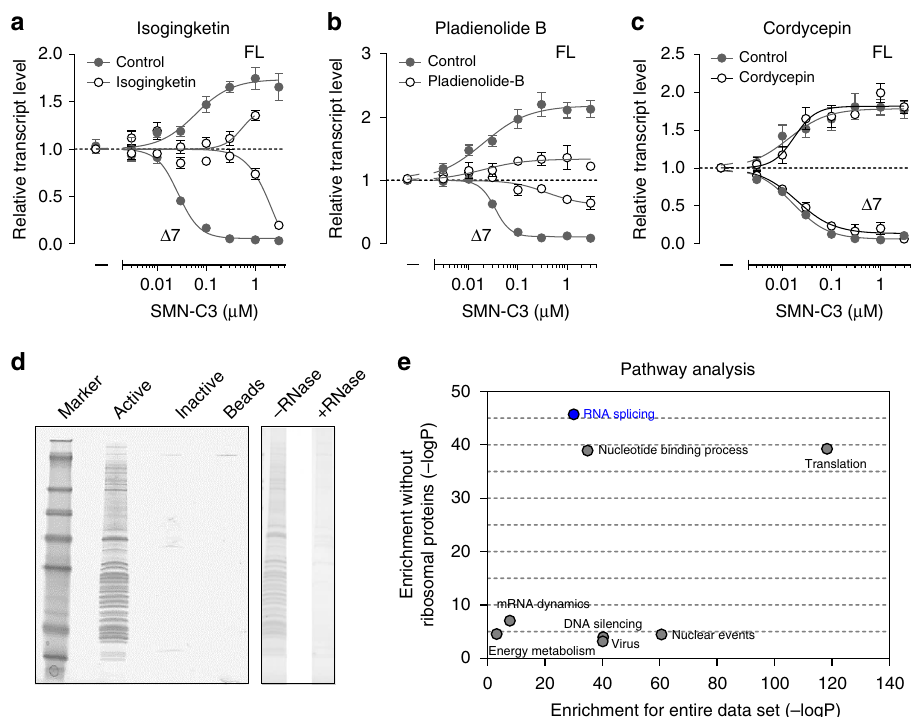
Fig. 1 Small molecule splicing modi fi ers act directly on the RNA splicing process. a , b , c RT-PCR analysis of SMN2 mRNA FL and Δ 7 relative transcript levels in SMA type 1 patient fi broblasts. SMN-C3 compound activity after 6 h treatment was investigated in the presence or absence of inhibitors of splicing or polyadenylation, namely 50 µ M isogingketin a , 100 nM pladienolide B b , or 40 µ M cordycepin c . d Coomassie gel after chemical proteomics showing proteins pulled down in the presence of Active vs. Inactive compound, as well as after RNase treatment. The full gel is illustrated in Supplementary Fig. 2H. e Pathway enrichment analysis of Active compound (SMN-C6), suggesting highest enrichment of mRNA splicing complexes by Active, together with other categories. Removal of ribosomal proteins from the list con fi rmed a selective enrichment of proteins involved in mRNA splicing or nucleotide binding. Data in a , b , c represent means ± standard error of the mean (SEM) of at least nine independent assessments per